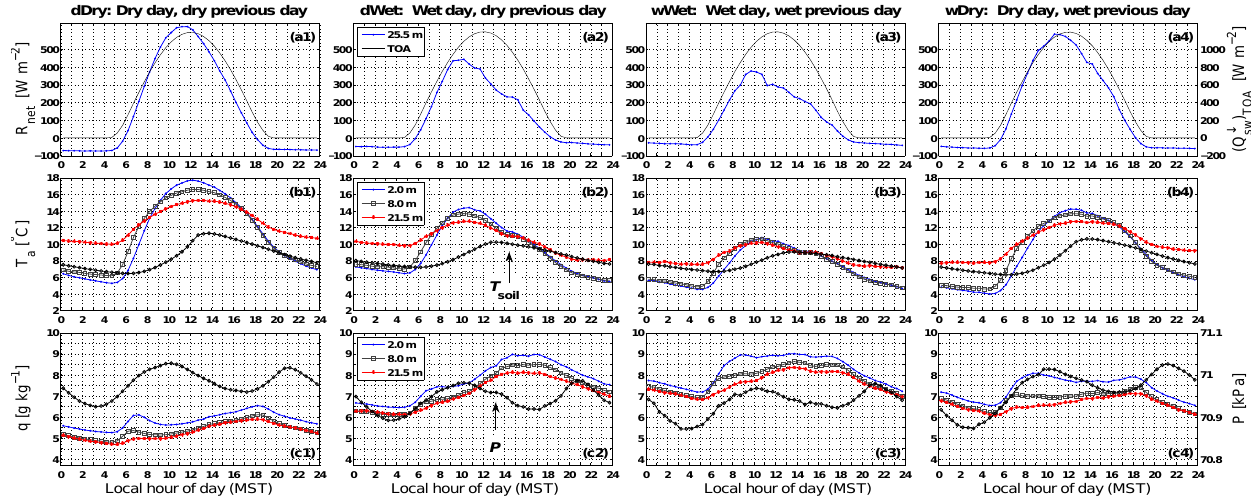
Figure 6. The warm-season mean diel cycle of (a1–a4) net radiation R net (left-hand axis) and top-of-the-atmosphere incoming shortwave ↓ radiation ( Q ) TOA (right-hand axis), (b1–b4) air and soil temperature T a , T soil , and (c1–c4) specific humidity q and barometric pressure SW P . Within each column, the data are separated into diel periods based on whether significant rain occurred on that day. A “wet” day has a total daily precipitation of at least 3mm (see text for further details). The legend in the 2nd column applies to all panels within each row.